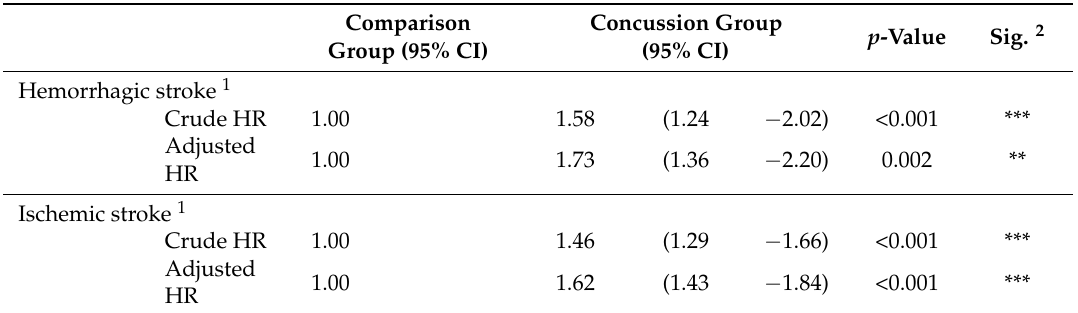
Table 3. Incidence rates, crude hazard ratio, adjusted hazard ratio of stroke in the comparison group and concussion group ( n = 27,304, 1998–2005).